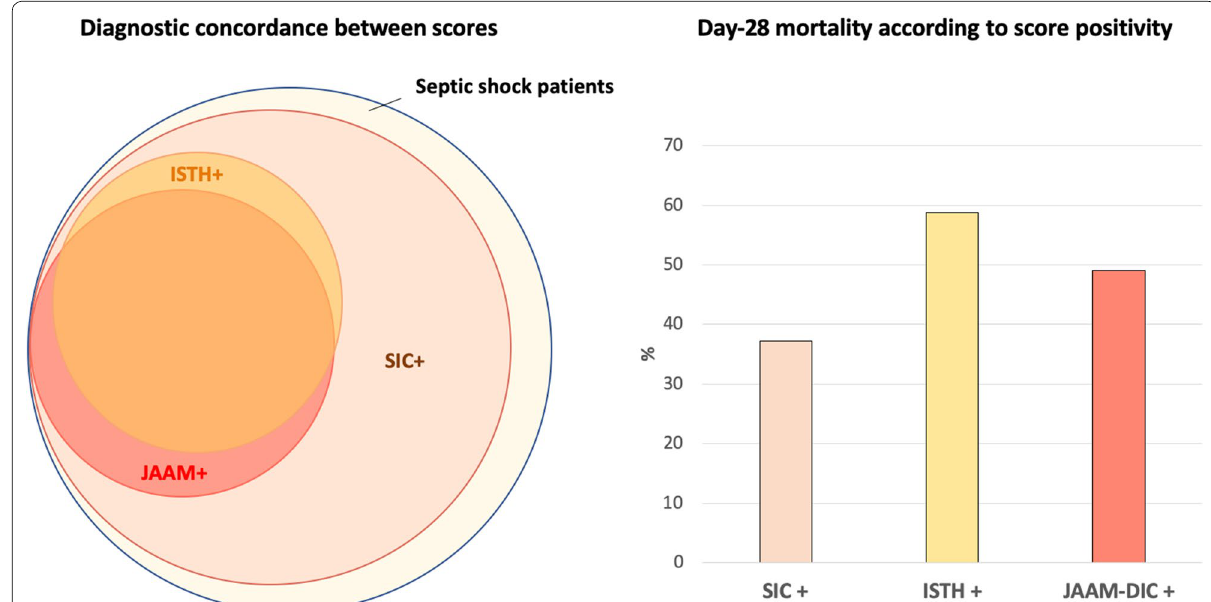
Fig. 1 Concordance between DIC scoring systems on admission for septic shock and corresponding mortality at D28. Total SIC score is 4 or more; total JAAM‑DIC score is 4 or more; total ISTH overt‑DIC score is 5 or more